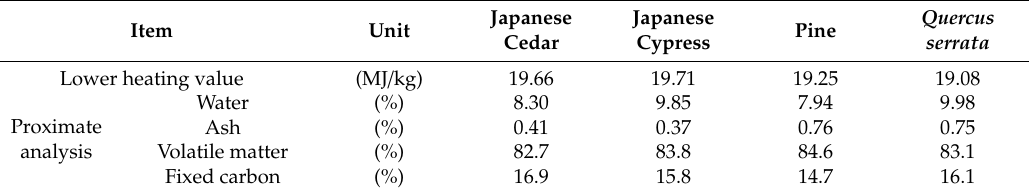
Table 3. Results of proximate